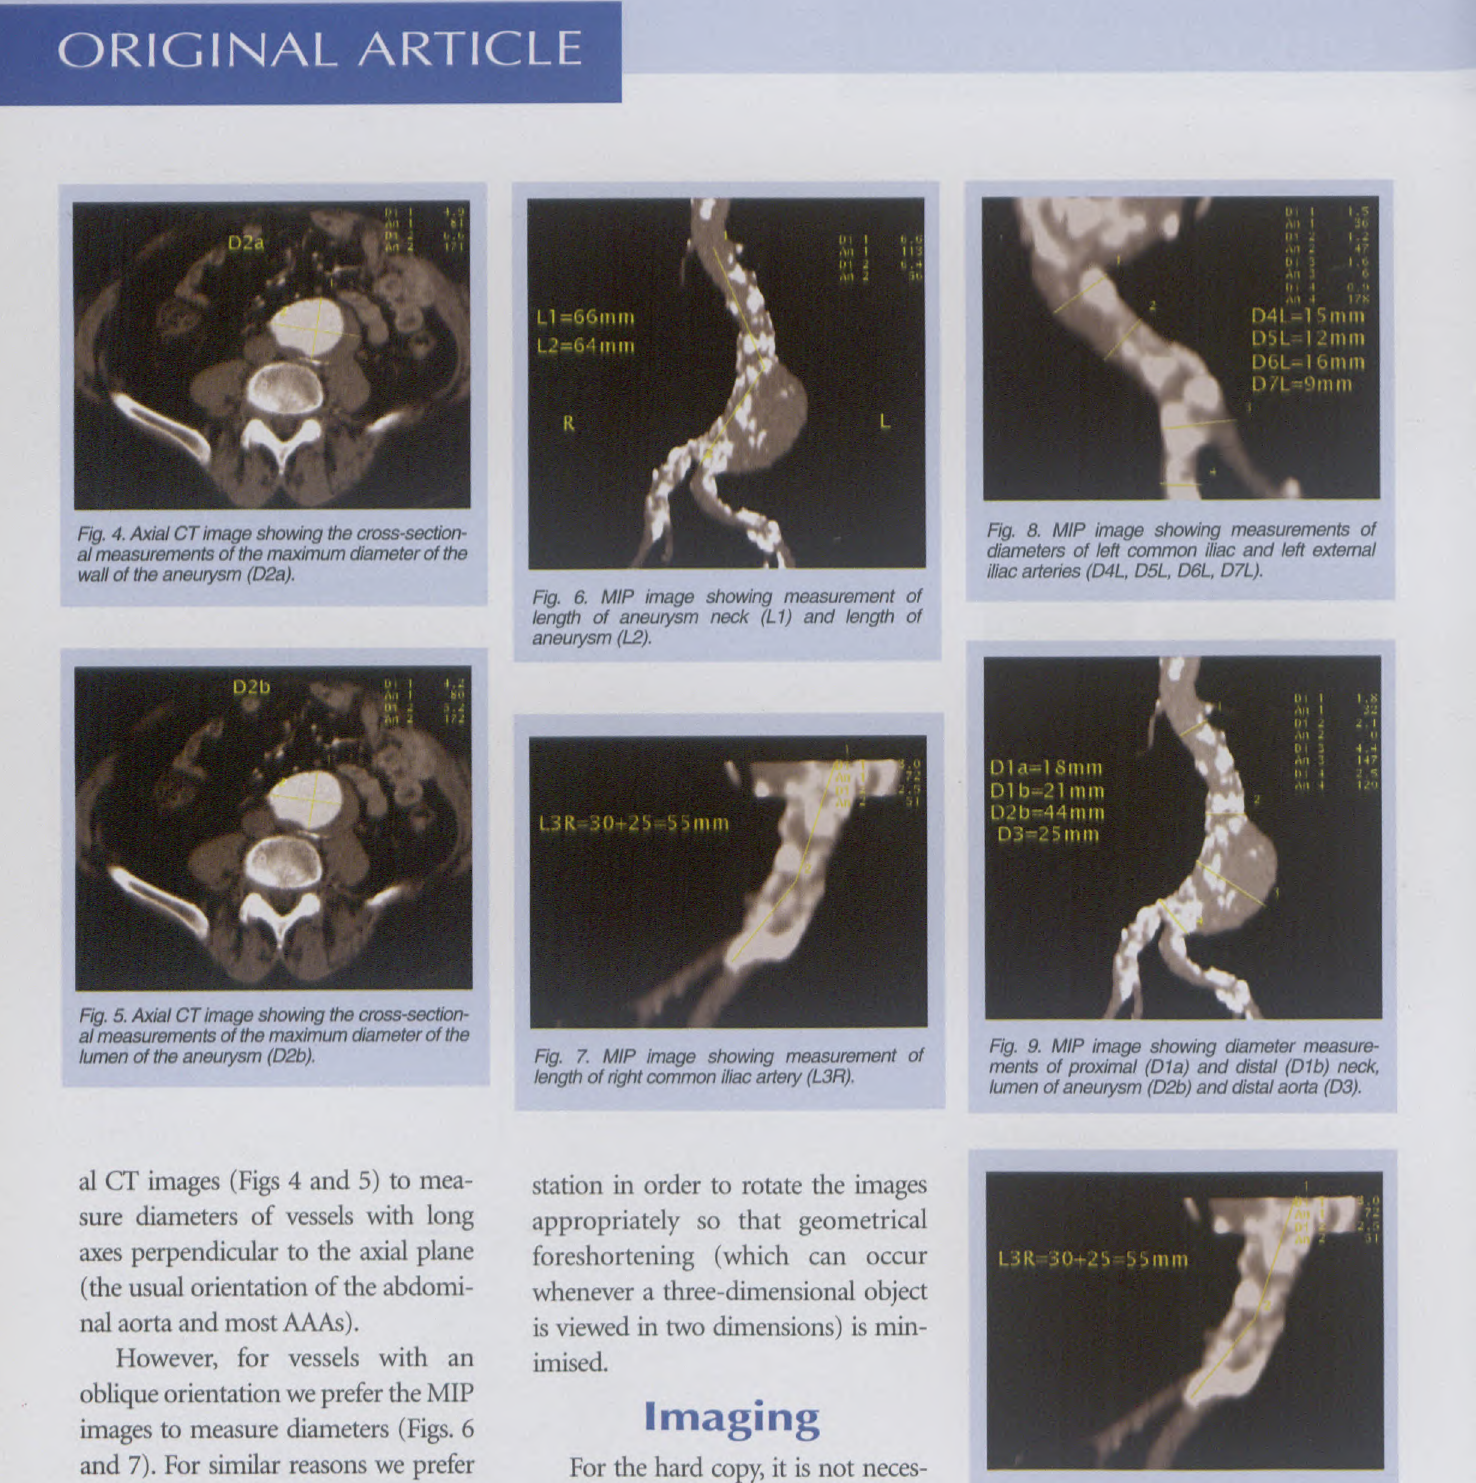
Fig. 10.MIP image showing length measurement of right common iliacartery